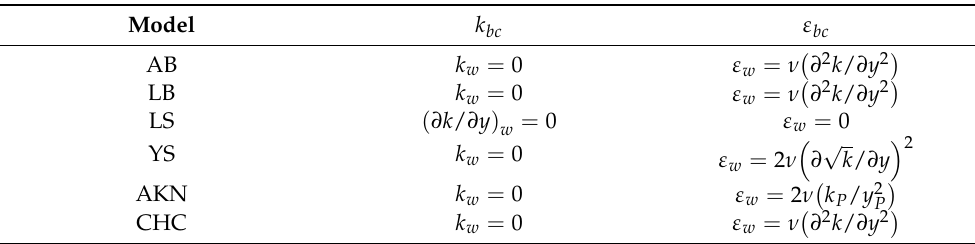
Figure 3. Grid independence test predicted by AB model. Table 3. Turbulent kinetic energy and dissipation rate boundary conditions of six low-Reynolds number k- ε